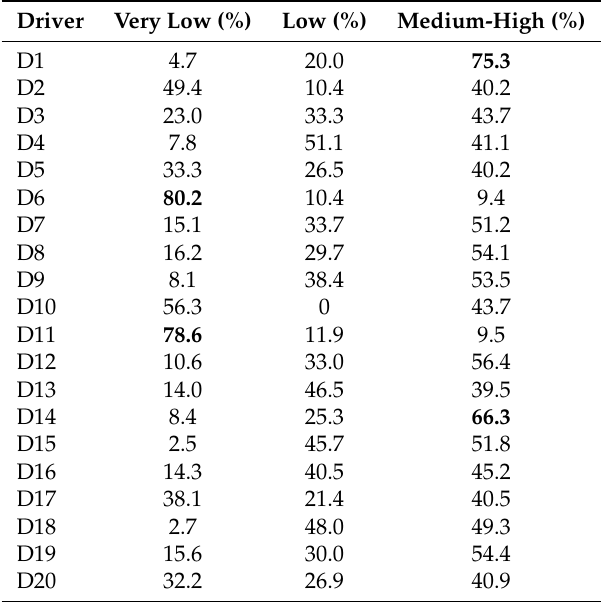
Table 3. Percentage of the route that each driver travels using different fuel-consumption driving styles (DSs) (three-cluster